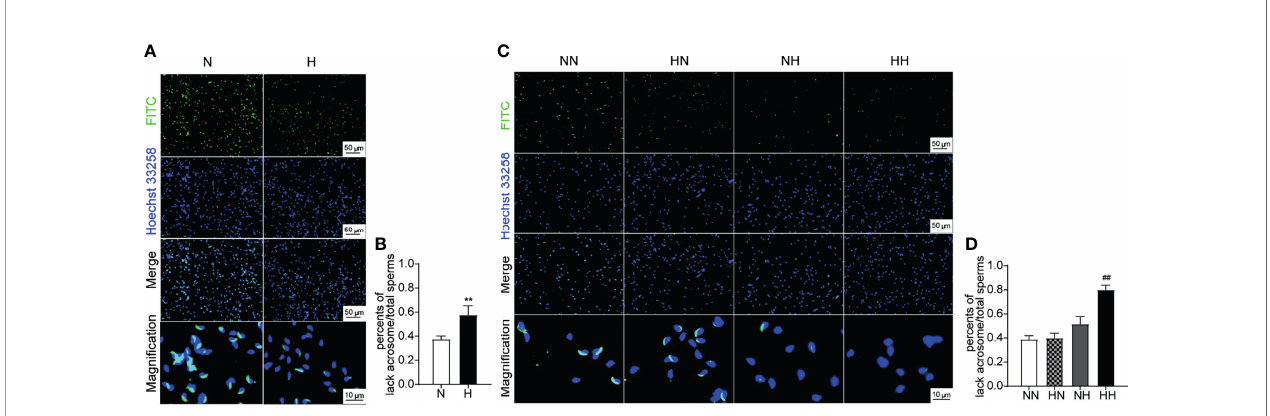
FIGURE 4 | Acrosome reaction and integrity induced by high-fat diet during sexual development Testicular tissue sperm PNA — FITC staining of 8-week and 16- week old mice (A, C) . The percentage of lack of acrosome were calculated (B, D) (n=3 for each group). Results are presented as mean ± SEM. **p < 0.01 vs the N group. ## p < 0.01 vs the